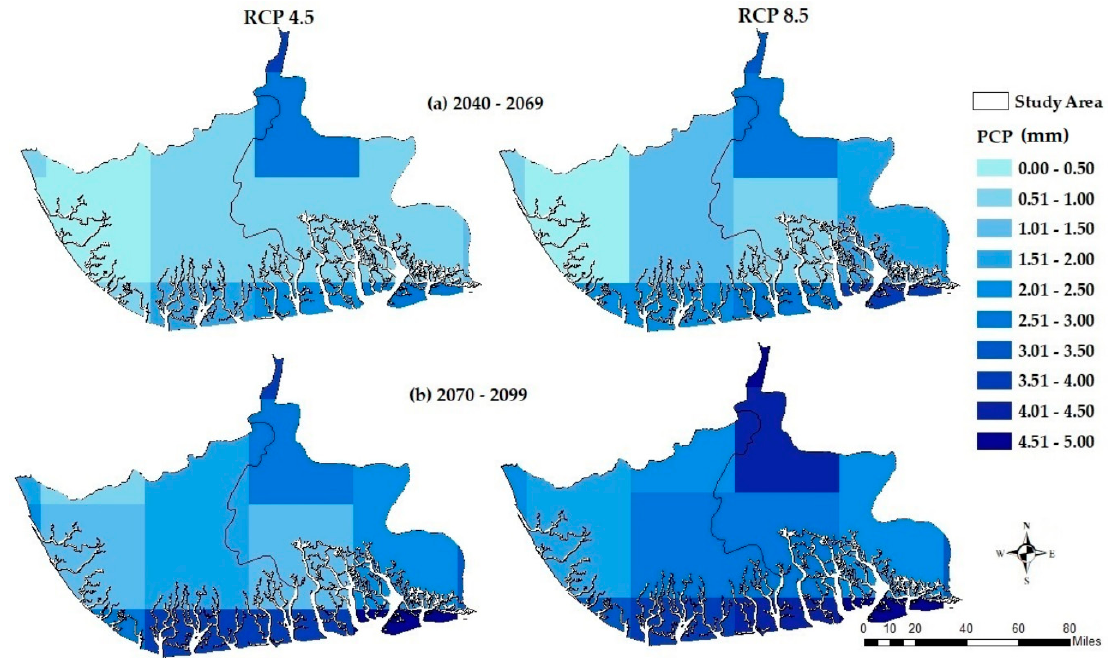
Figure 6. Spatial distribution of percentage changes in average annual prcp, for periods ( a ) 2040–2069 and ( b ) 2070–2099 compared to the base period 1980–2005 for RCP4.5 and RCP8.5.